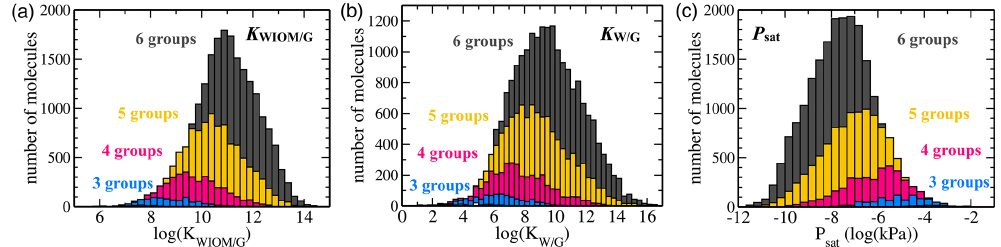
Figure 7. Histograms of C10 TopFP–KRR predictions for (a) K WIOM/G , (b) K W/G , and (c) P sat . The histograms are divided into different numbers of functional groups. Molecules with two or fewer functional groups have been omitted from these histograms because their total number is very low in the C10 dataset.